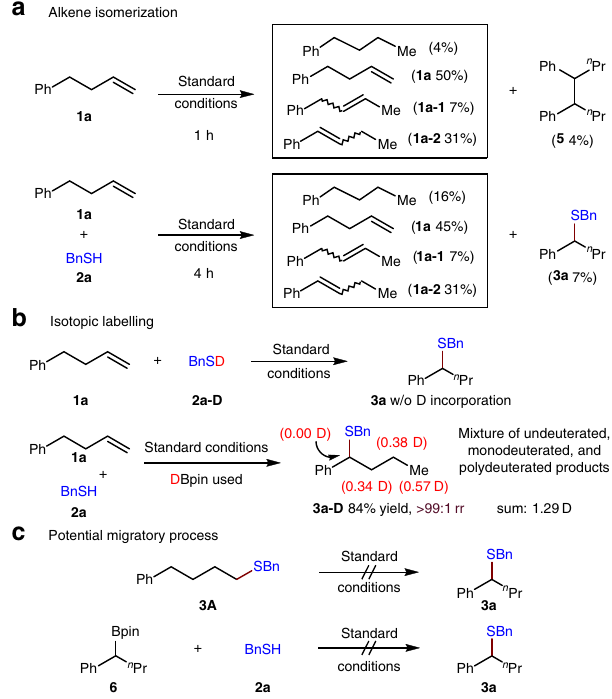
Fig. 5 Mechanistic studies of chainwalking. a Alkene isomerization.